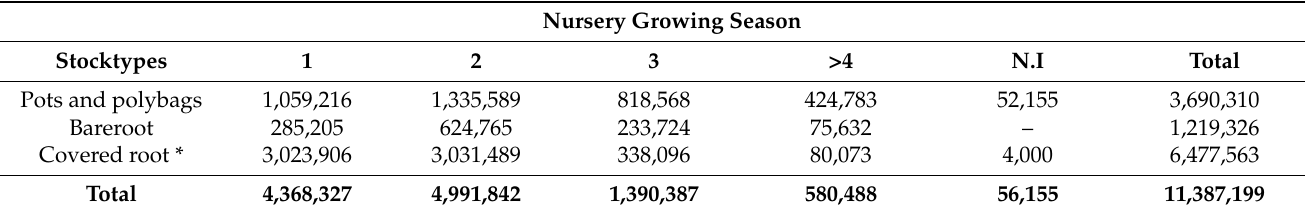
Table 2. Number of native plants produced between 2016 and 2019 according to stocktypes and the nursery growing season. Nursery Growing